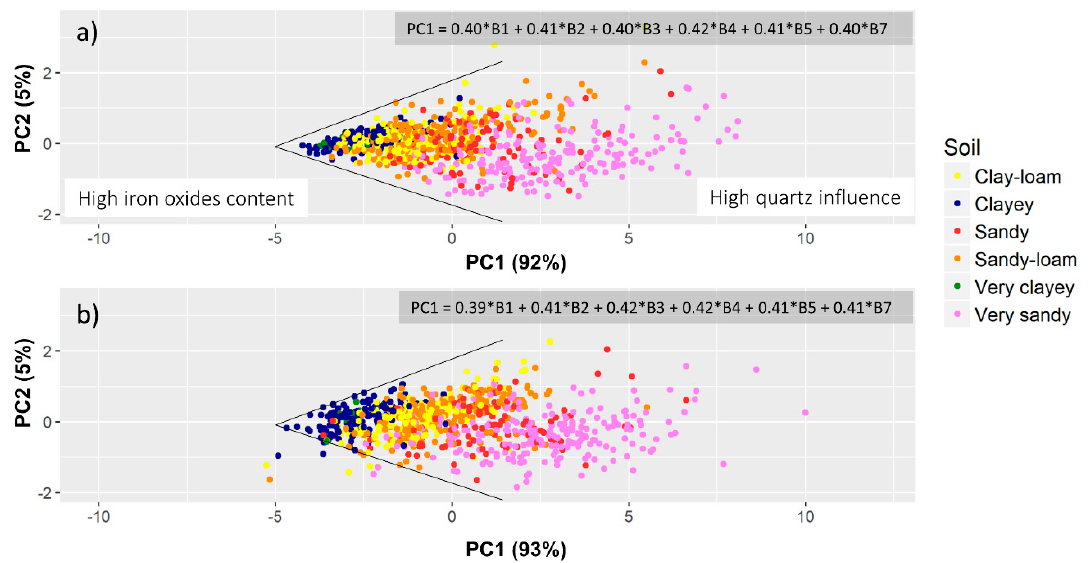
Figure 4. Principal component (PC) analysis of the spectral reflectance of convolved laboratory spectra ( a ) and Temporal Synthetic Spectral Reflectance (TESS) from the Synthetic Soil Image (SYSI) ( b ). The colors of samples are related to the soil texture classes.